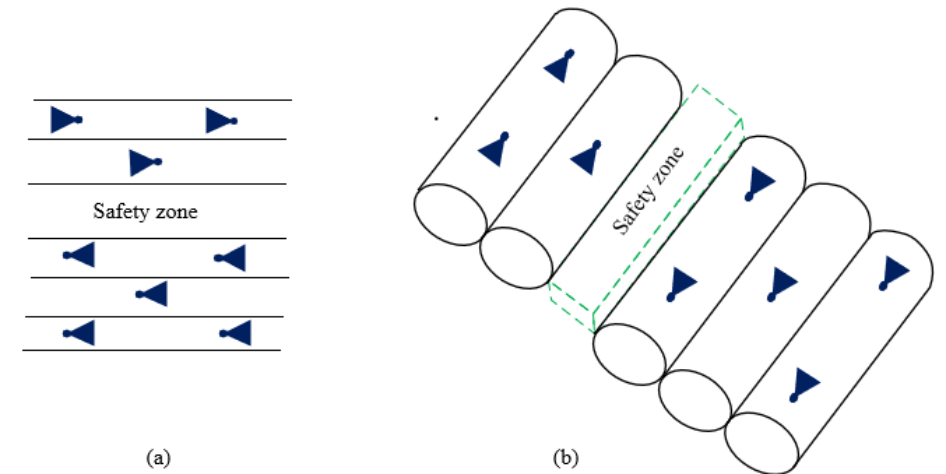
Figure 9. Multi-lanes in two ways: ( a ) vertical view, ( b ) 3D view.